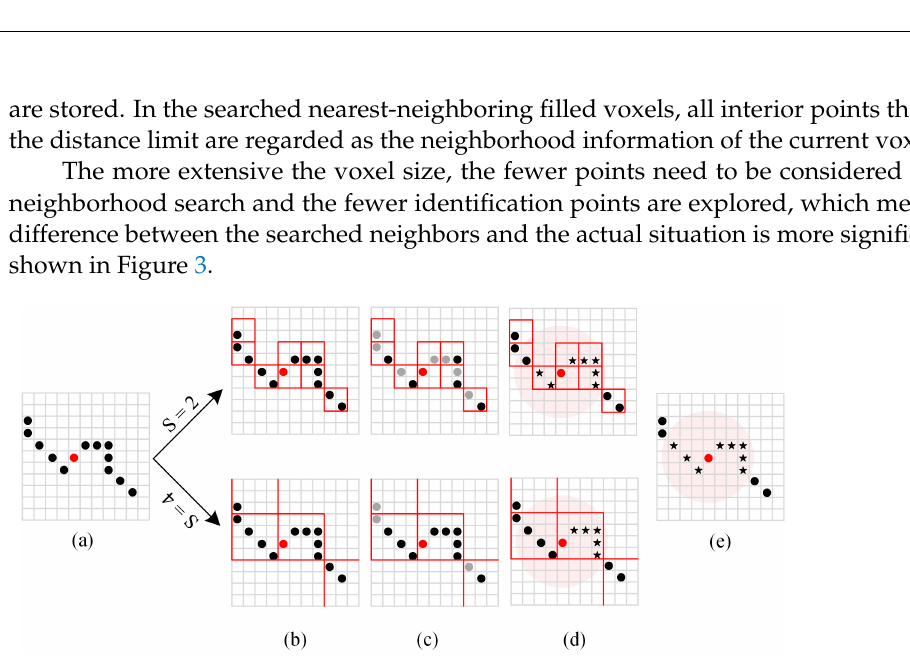
whole cloud containing hundreds of thousands of points is laborious. As a result, the re-